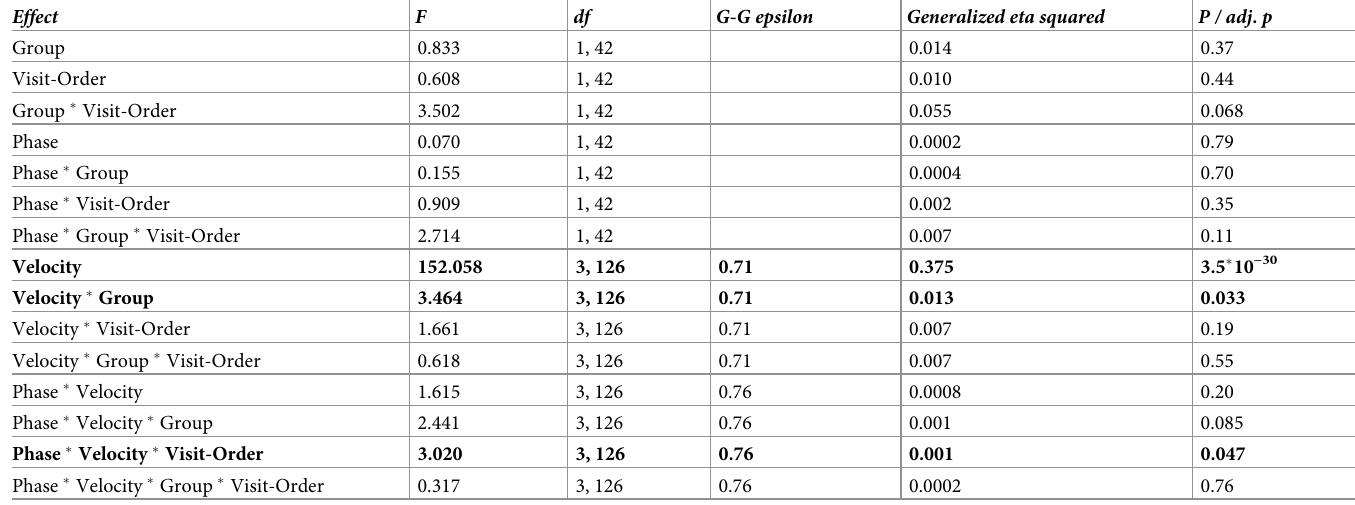
Table 5. ANCOVA results for log10-transformed GR